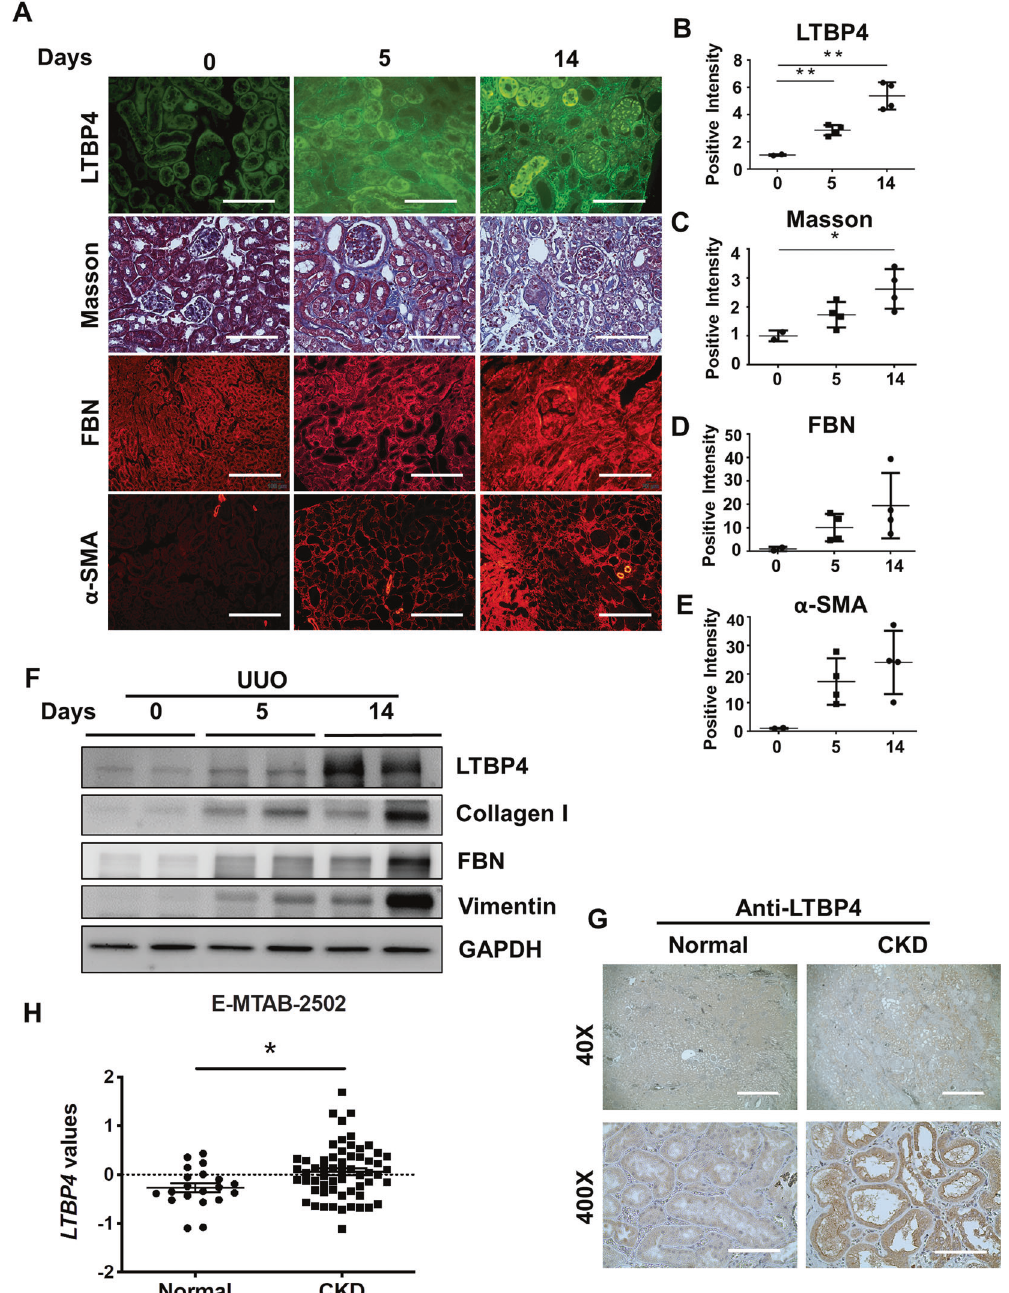
Fig. 1 LTBP4 expression is associated with tubulointerstitial fi brosis in mouse and human kidneys. A – F Wild-type mice were subjected to tubulointerstitial fi brosis by unilateral ureteral obstruction (UUO) for the indicated time points. A Representative histological images with Masson ’ s trichrome and immuno fl uorescence staining of kidneys after UUO. Scale bars, 100 μ m. Computer-assisted quantitative analyses of histological images for Ltbp4 ( B ), Masson ’ s trichrome (Masson) ( C ), Fibronectin (FBN) ( D ), and α -SMA ( E ) are shown. F Protein expression of Ltbp4, collagen I, fi bronectin, and vimentin in the kidneys of mice subjected to UUO, as detected by immunoblotting. GAPDH served as an internal control. Representative images from three independent experiments are shown above. n = 2 mice in 0-day group; n = 4 mice in 5- and 14-day groups. G Representative immunohistochemical images showing that LTBP4 was predominantly expressed in the kidneys of a patient with diabetic nephropathy compared to a normal control individual. Scale bars: 1 mm in ×40 and 100 μ m in ×400 magni fi cations. Representative images from three independent experiments are shown above. ( H ) LTBP4 was upregulated in fi brotic kidneys, which was analysed in microarray data set: ArrayExpress_E-MTAB-2502. Normal: health individual; CKD: chronic kidney disease. Data are presented as the mean ± SEM. * p < 0.05, ** p <